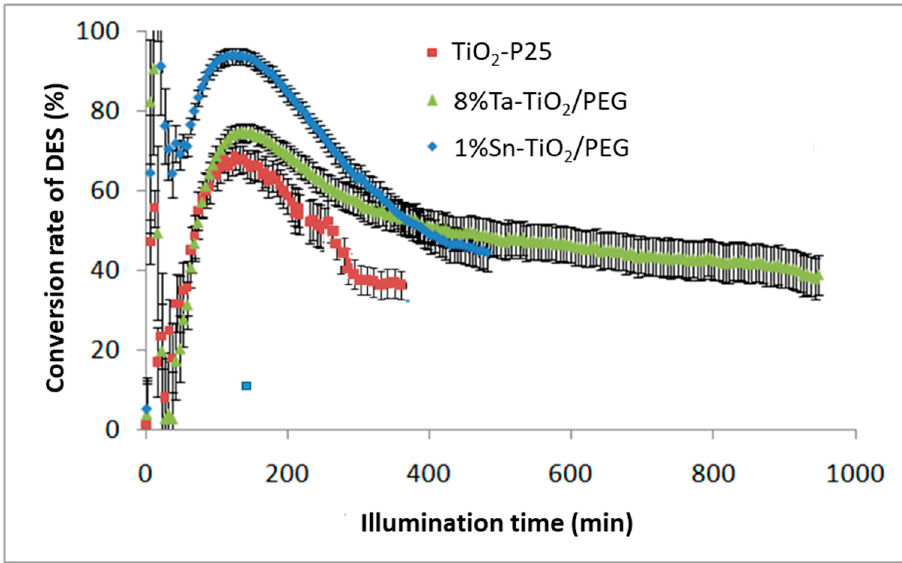
Figure 6. Photo-oxidation of DES under UV-A of TiO 2 P25, 8% Ta-TiO 2 /PEG and 1% Sn-TiO 2 /PEG supported on four samples of β -SiC foams.